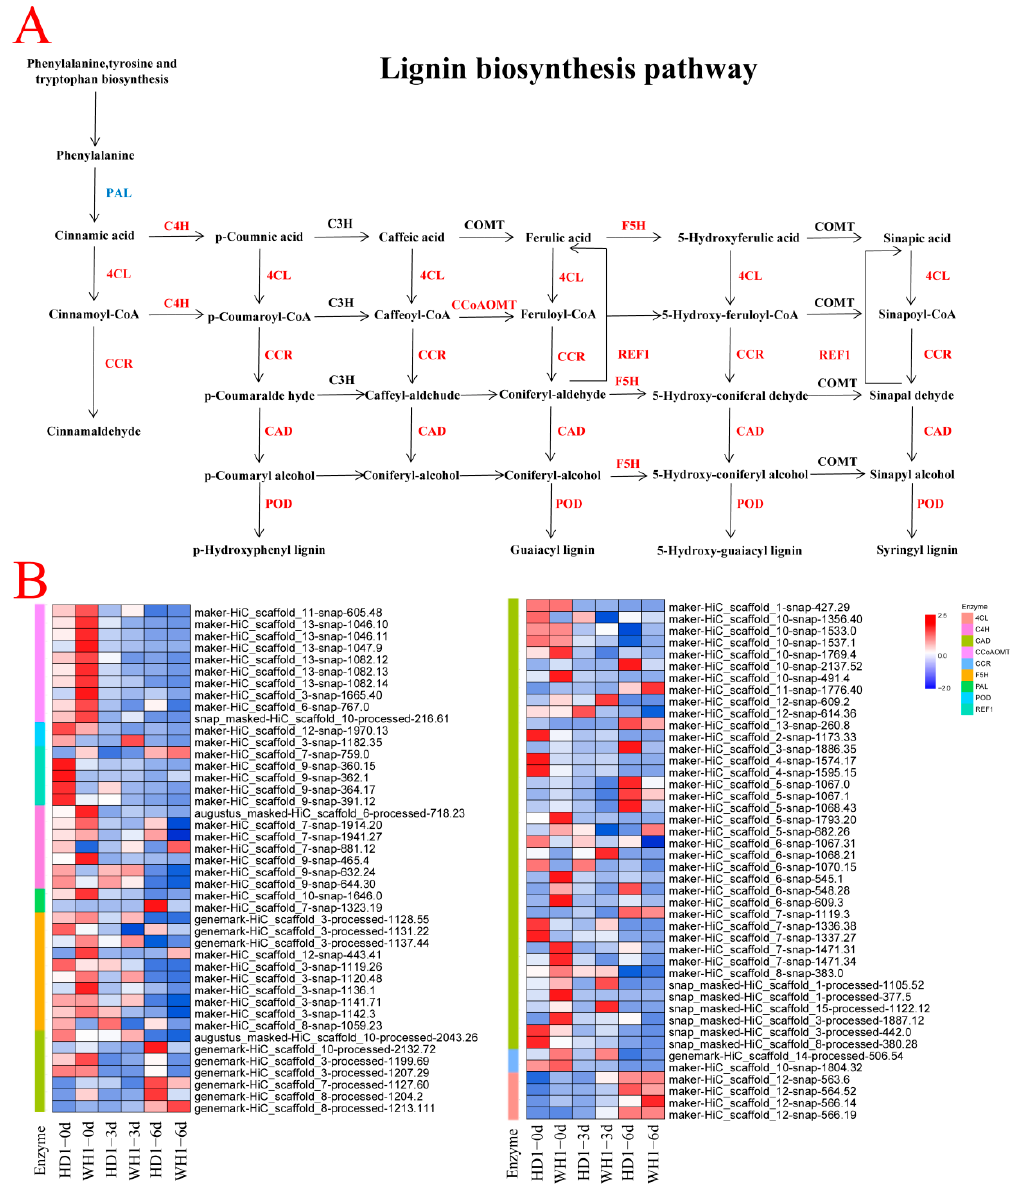
Figure 6. Expression analysis of DEGs enriched in the lignin biosynthesis pathway. ( A ): DEGs enriched in the lignin biosynthesis pathway in C. vietnamensis leaves. ( B ): Heatmap of lignin biosynthesis-related gene expression. PAL, phenylalanine ammonia-lyase; C4H, trans-cinnamate 4-monooxygenase; 4CL, 4-coumaric acid: CoA ligase; CCR, cinnamoyl CoA reductase; CAD, cinnamyl alcohol dehydrogenase; POD, peroxidase; COMT, caffeate 3-O-methyltransferase; CCoAOMT, caffeoyl-CoA O-methyltransferase; F5H, ferulate 5-hydroxylase; REF1, coniferyl-aldehyde dehydrogenase. Values are the average FPKM value of each sample in each group. Genes in red or blue refer to up- or downregulation responding to drought, respectively.